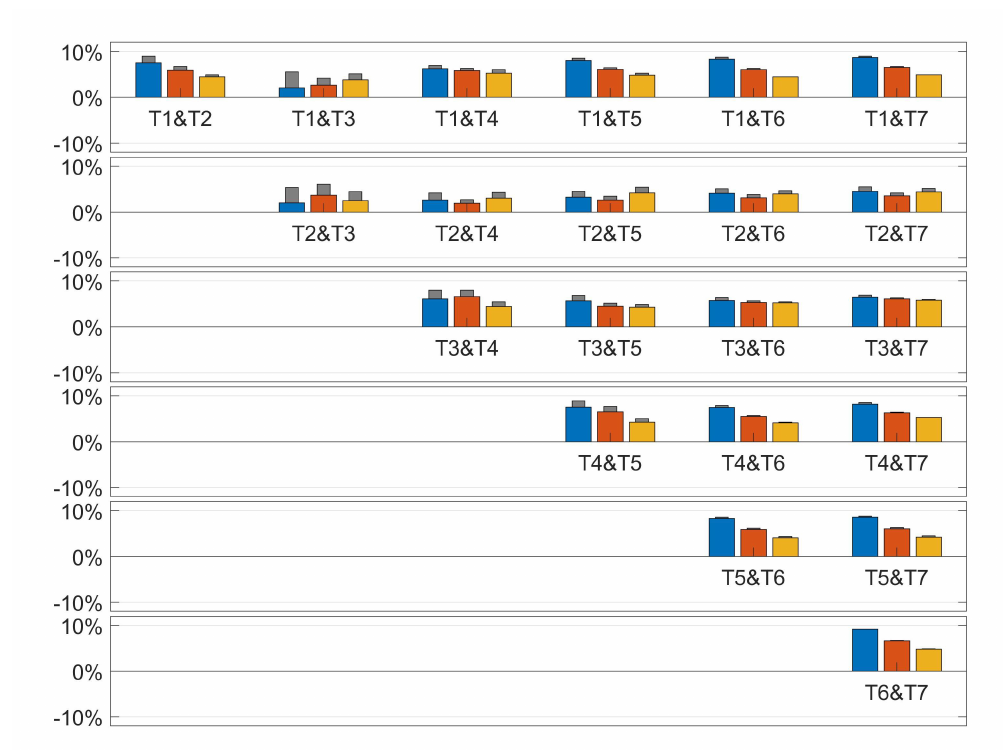
Figure 5. Relative power gain by AWC when 2 out of the 7 wind turbines in a row are not operational.